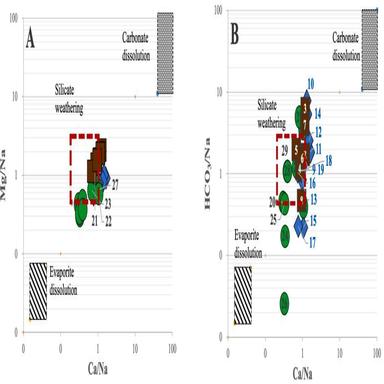
Groundwater chemistry is largely controlled by silicate weathering and evaporation dissolution.